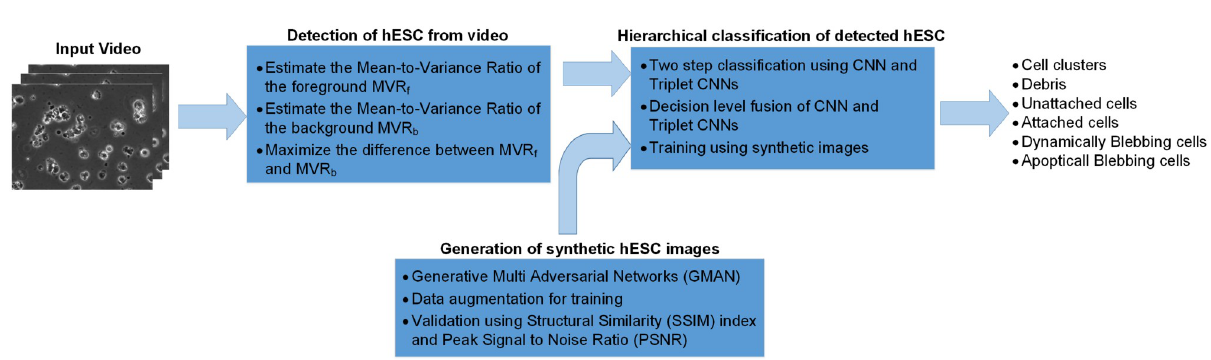
Fig 5. Workflow of DeephESC 2.0 is split into three modules namely : Detection of hESC from video, Generation of synthetic hESC images and hierarchical classification of the hESC images into six different classes.